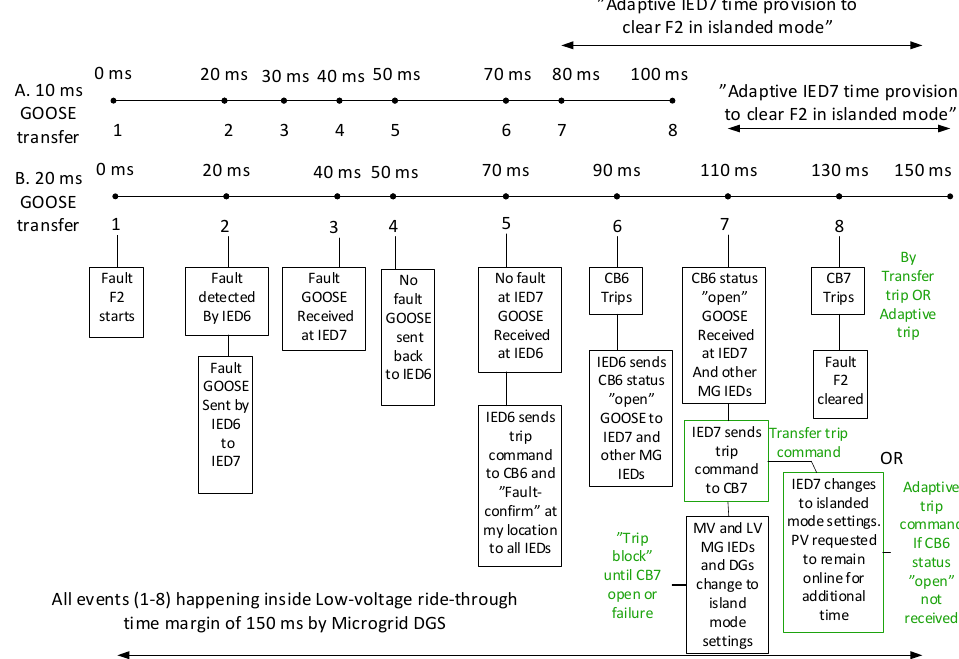
Figure 8. Fault F2 clearance time with 10-ms and 20-ms GOOSE message transfer delays (CB7 can trip by transfer trip GOOSE from IED6 or by adaptive IED7 using islanded mode settings).